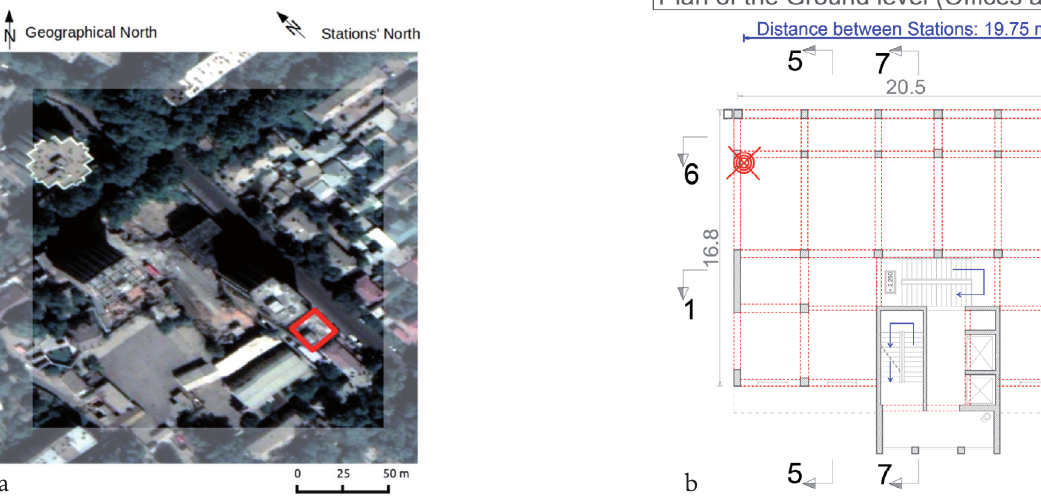
Figure 5. (a) Building floor plan and (b) cross-section of the RC dual system building under construction (Figure 2,III). The locations of the stations are marked with red